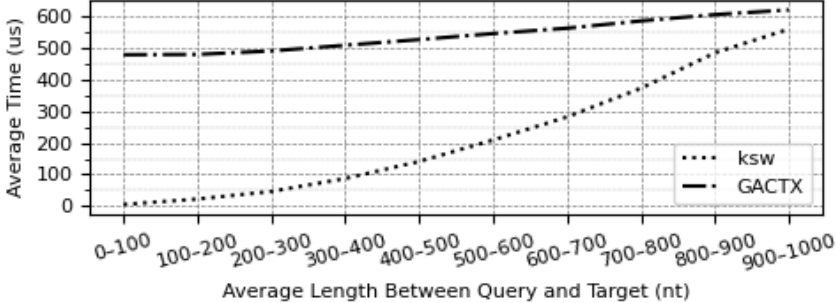
Figure 7. Ksw function and GACT-X average processing times per length for anchor-separated sub-sequences for the simulated dataset. The processed subsequences are classified by their length, in 100 base intervals, up to 1000 bases. The times are longer for GACT-X (dashed and dotted curve) compared to the ksw function execution (dotted